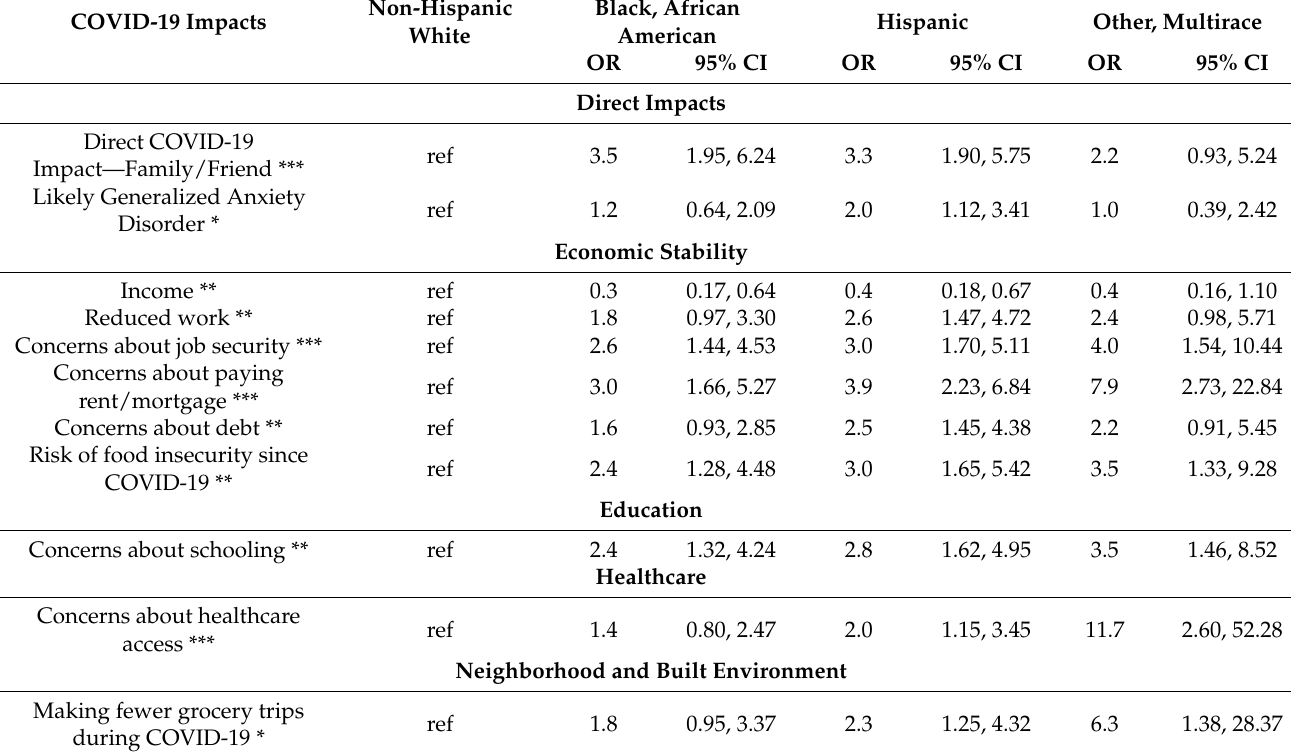
Table 4. Odds of primary and secondary COVID-19 impacts by race and ethnicity (unadjusted odds